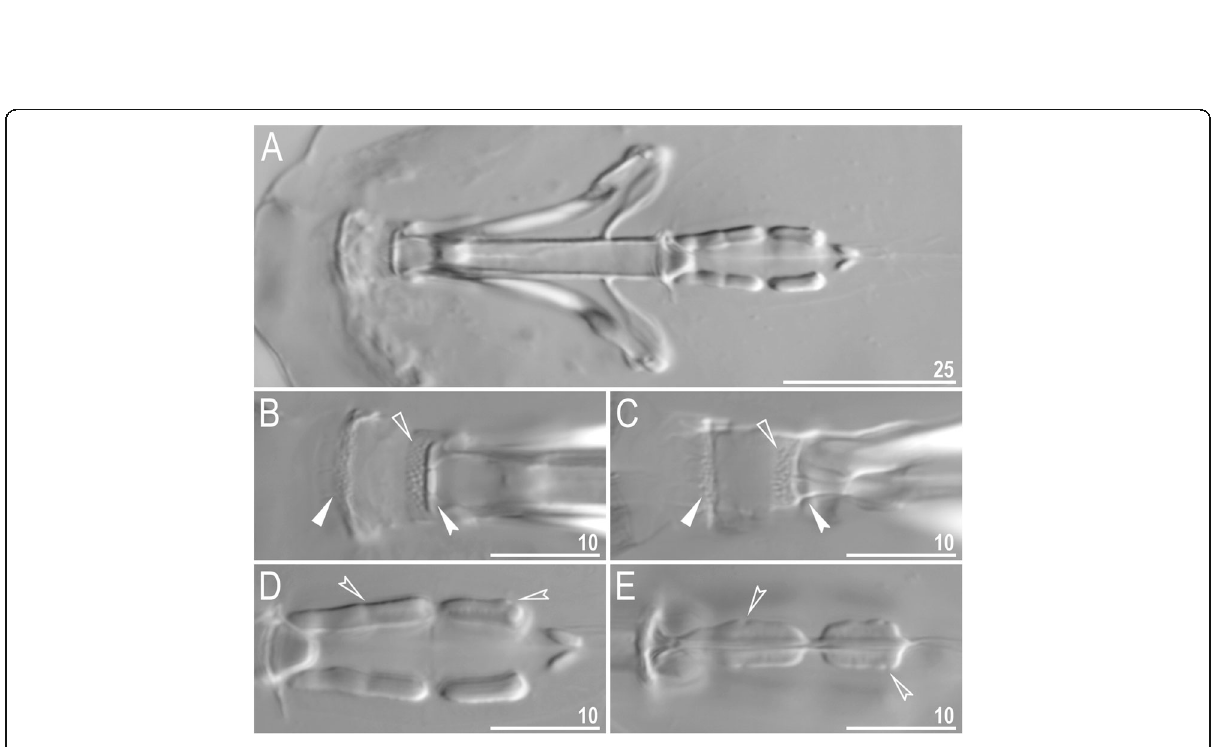
Fig. 25 Macrobiotus ripperi sp. nov. from Poland (PL.015) – buccal apparatus seen with LCM: a – an entire buccal apparatus; b – c – the oral cavity armature, dorsal and ventral teeth, respectively; d – e – placoid morphology, dorsal and ventral placoids, respectively. Filled flat arrowheads indicate the first band of teeth, empty flat arrowheads indicate the second band of teeth, filled indented arrowheads indicate the third band of teeth, and empty indented arrowheads indicate central and subterminal constrictions in the first and second macroplacoids. Scale bars in μ